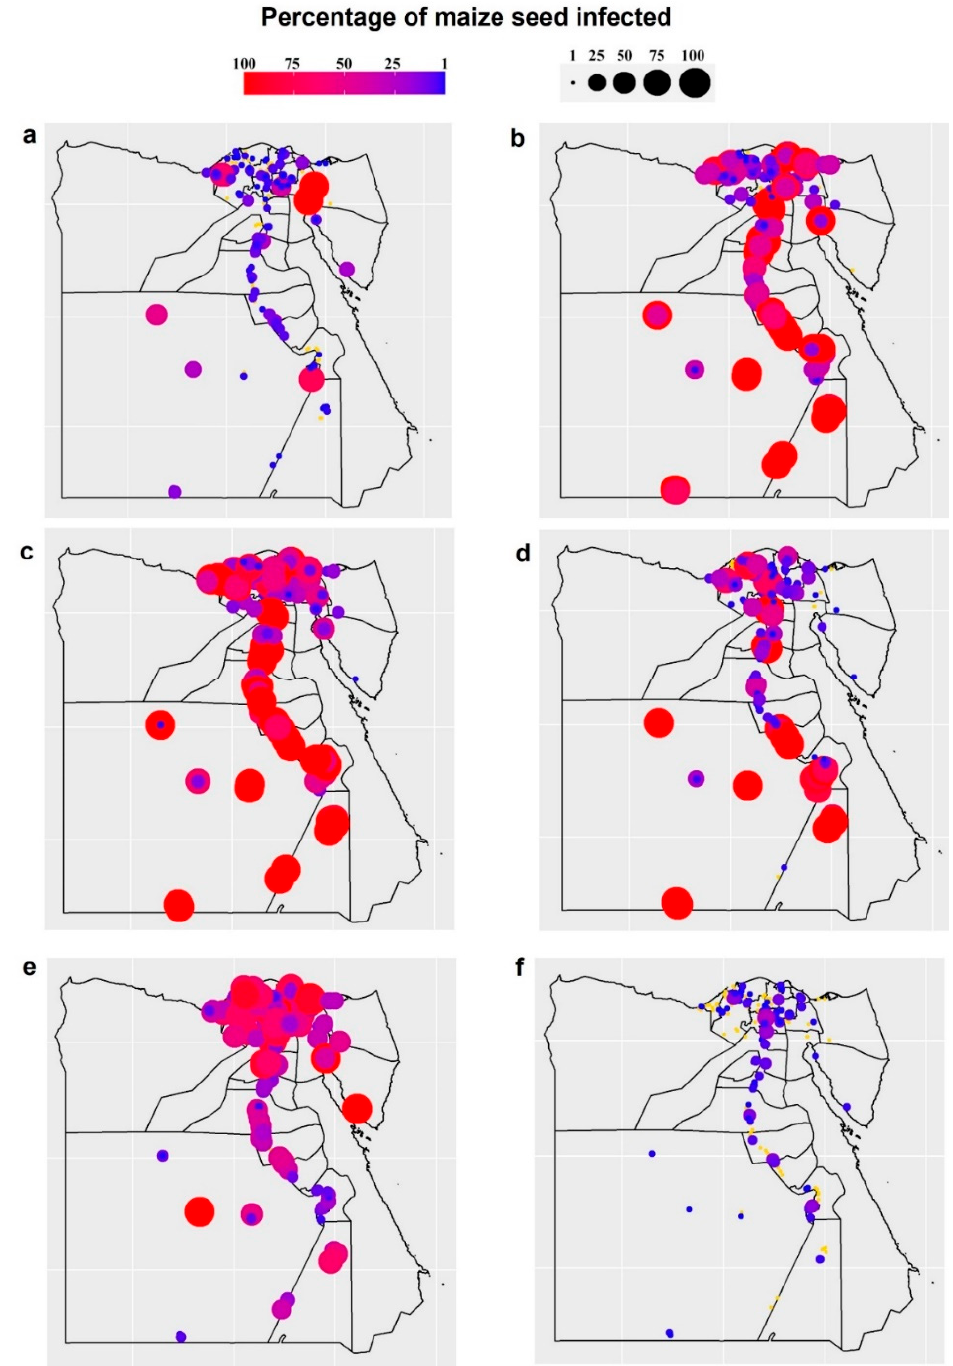
Figure 6. Geographical distribution and incidence (%) of key maize seed-borne fungi recovered from grain samples collected from the 25 maize-growing governorates in Egypt, where ( a ) Alternaria alter- nata ( b ) Aspergillus flavus , ( c ) A. niger , ( d ) Cladosporium spp., ( e ) Fusarium verticillioides , ( f ) Penicillium spp. (circles in yellow indicate no occurrence of the